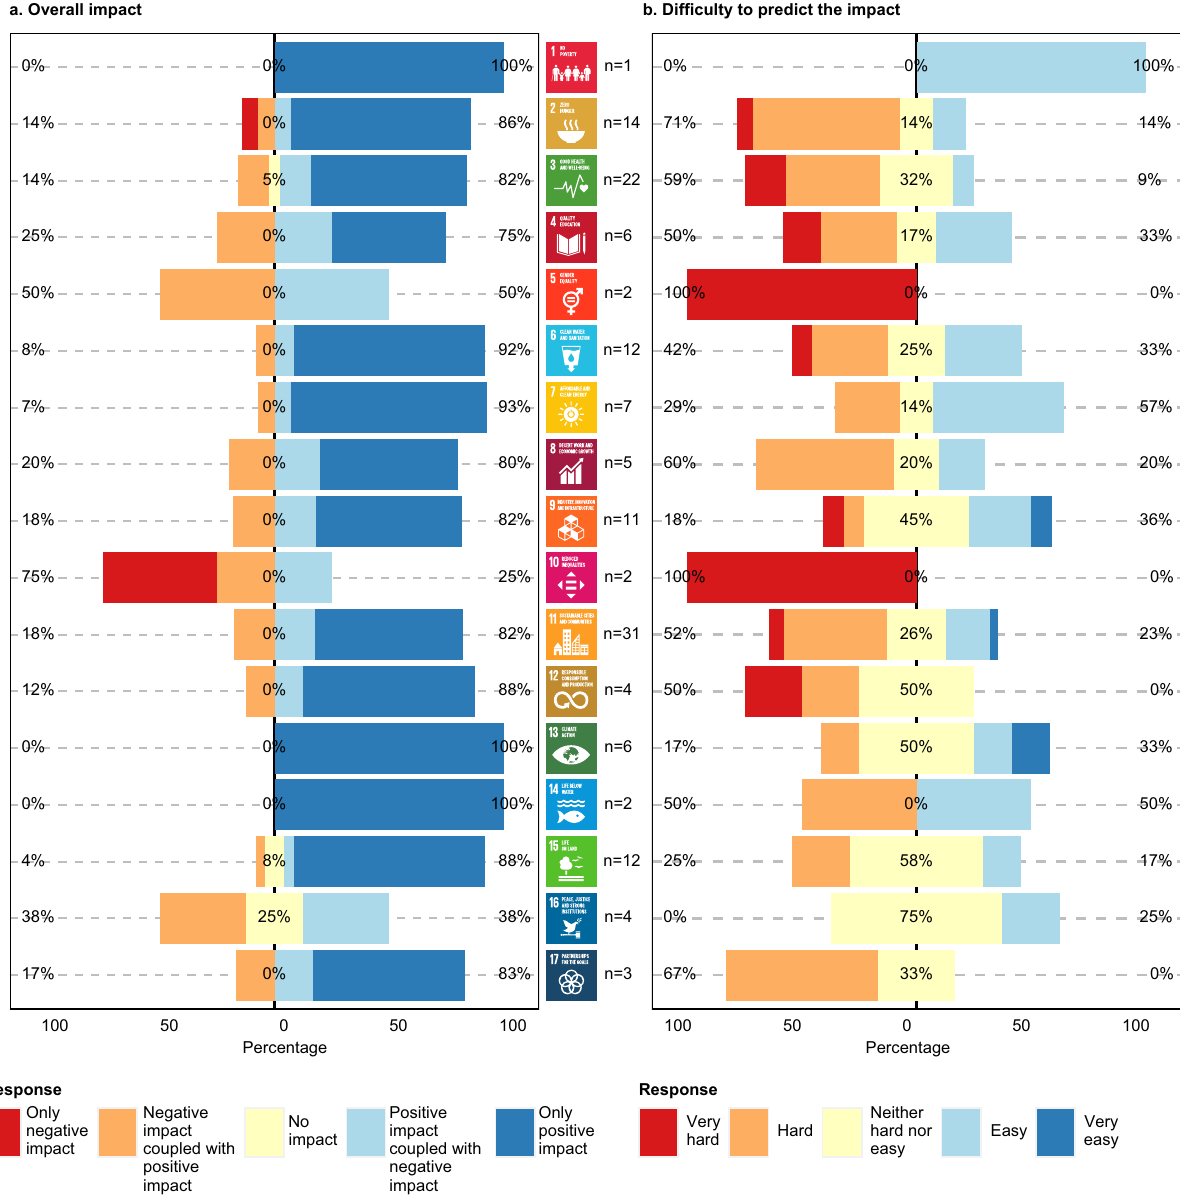
Fig. 4 Impact of RAS on the SDGs and the dif fi culty to predict said impact, as rated by the online questionnaire participants. a Overall impact of RAS on the SDGs; b Dif fi culty to predict the impact of RAS on the SDGs. Percentage values indicate the proportion of participants giving negative, neutral and positive scores. See Fig. 1 and https://www.un.org/sustainabledevelopment/ for SDG icon de fi nitions and further information. The content of this publication has not been approved by the United Nations and does not re fl ect the views of the United Nations or its of fi cials or Member